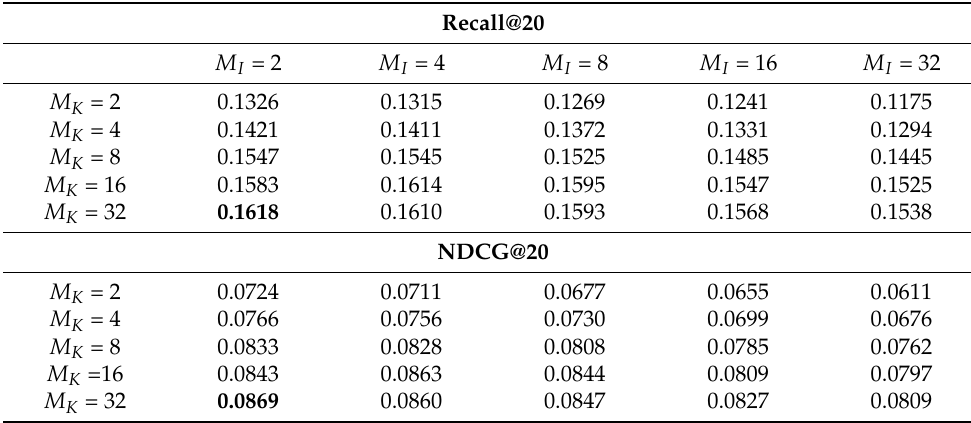
Table 5. Impact of the neighbor number for Amazon-Book.